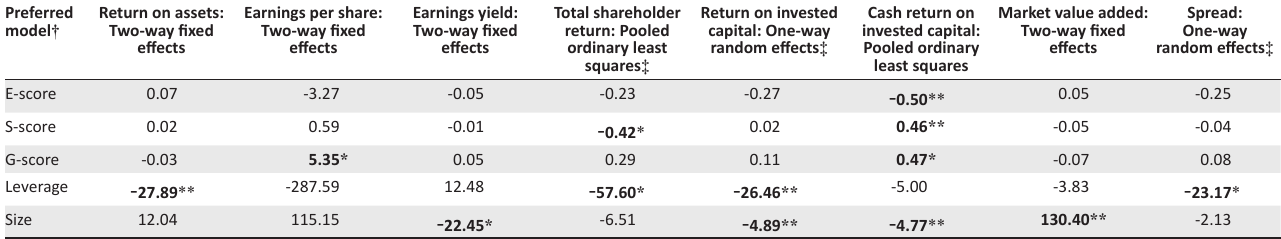
TABLE 6: Regression results for the individual environmental, social and corporate governance disclosure scores for the industrials sector. Preferred model